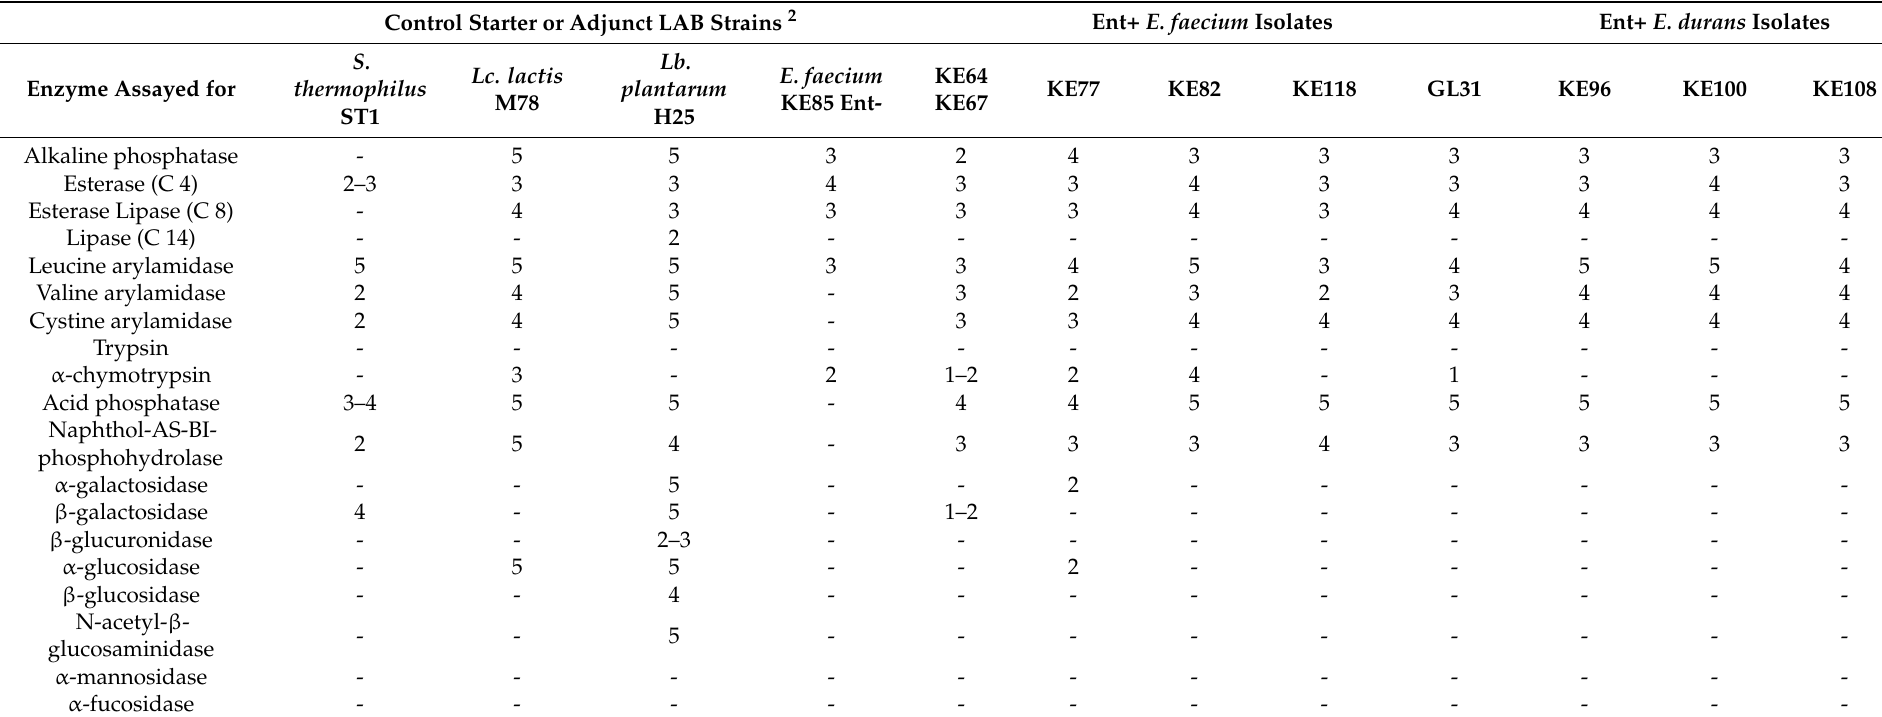
Table 5. Enzymatic activity reactions determined by the API ZYM method of the single or multiple enterocin-producing Enterococcus Greek cheese isolates 1